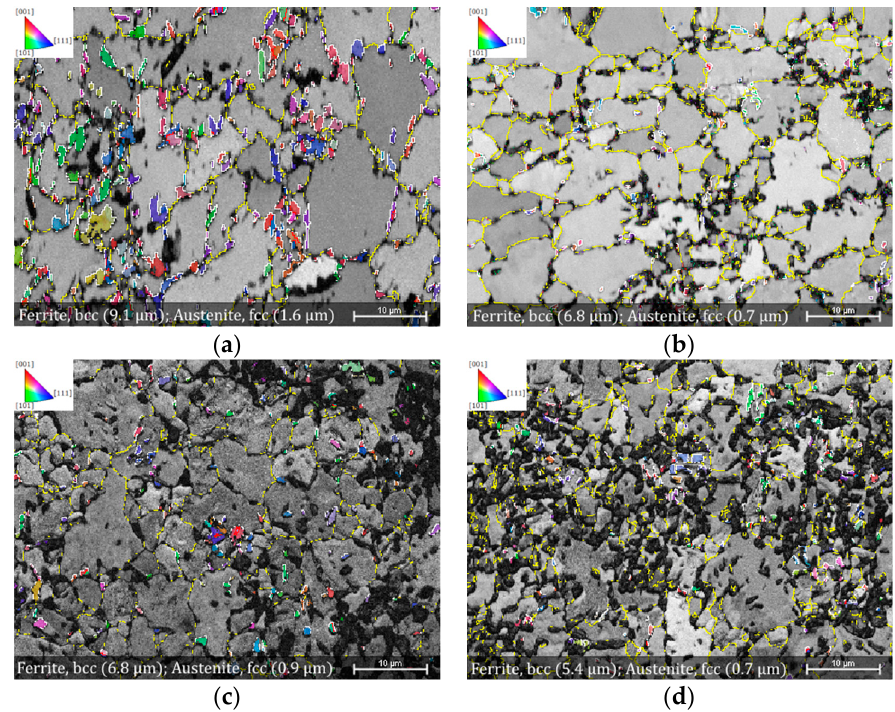
Figure 5. E lectron back-scatter diffraction (EBSD) pattern quality maps (PQM) phase maps of austenite (fcc) in inverse pole figure (IPF) X colouring and ferrite (bcc) and austenite (fcc) grain sizes. ( a ) Steel A 810; ( b ) Steel B IBT 420; ( c ) Steel B IBT 450; and ( d ) Steel B IBT 480.